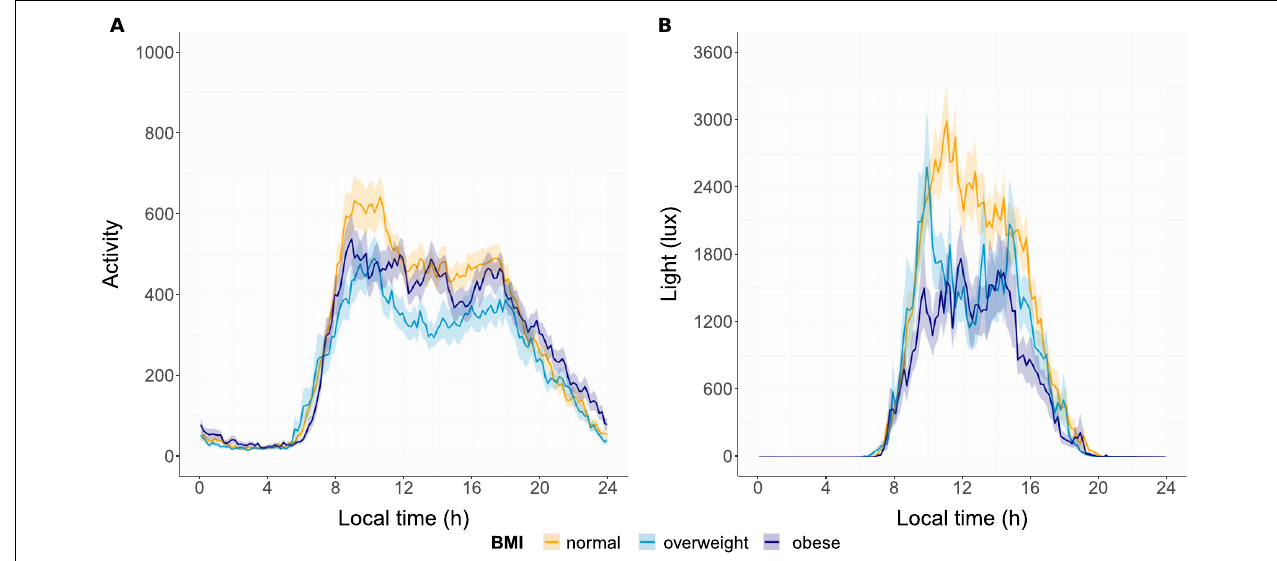
FIGURE 2 | Mean activity (A) and light (B) profiles of each group. The means (bold line) and standard error (shadow) are presented for the normal-weight group (orange), overweight group (light blue), and obese group (dark blue).